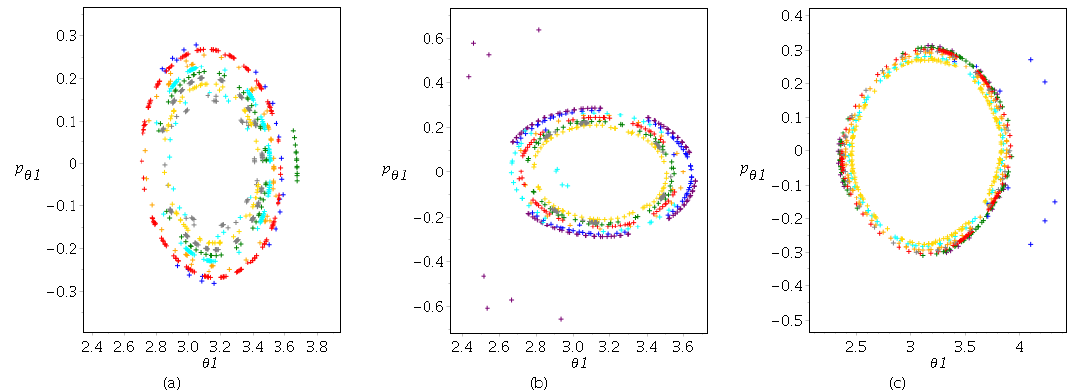
Figure 5 . Sample Poincar(cid:19)e plots for the ansatz (4.16), here plotted for m = 1 ; (cid:20) = 0 : 6, and varying values of the deformation parameter q . (a) q = 1, (b) q = 1 : 1 and (c) q = 1 : 65. The total energy is restricted to H = 0 due to the Virasoro